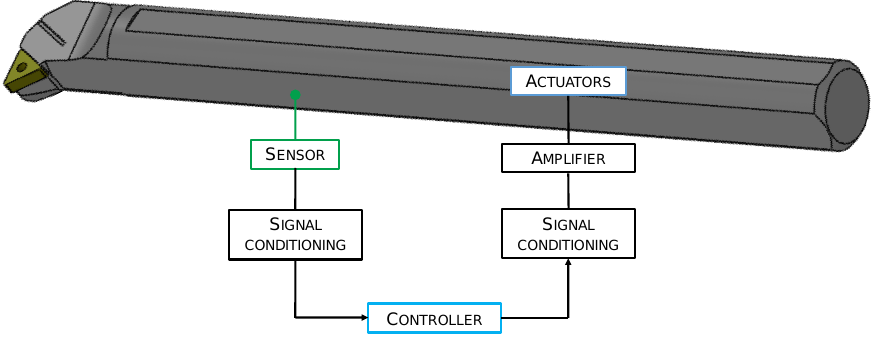
Figure 1. Active boring bar scheme.